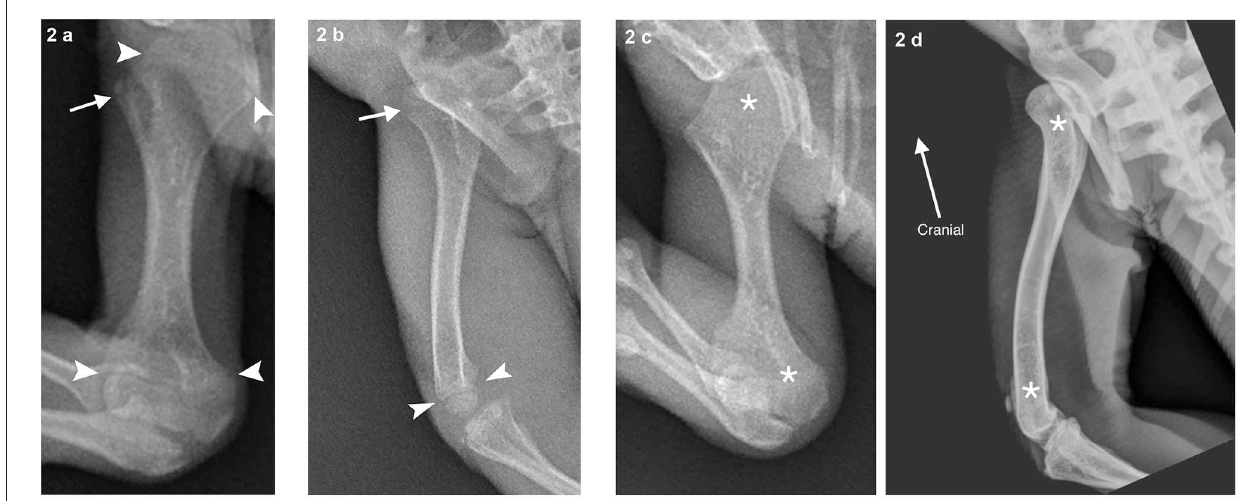
FIGURE 2 | (a) An individual with open proximal and distal humeral physes (growth plates; indicated by arrowheads) evidenced by linear lucencies separating the metaphyses (transition from diaphysis to physis/growth plate) and epiphyses (end of the long bone that supplies the articular surface of the joint). The apohysis (separate center of ossification for attachment of soft tissue structures) of the greater tubercle is also open (arrow). (b) Demonstrates an individual (464E22425F) with visible open distal femoral physis (arrowheads) and proximal femoral physis of the femoral head (arrow). (c) (4669670B06 humerus, asterisks) and (d) (green iguana left femur, asterisks) shows an individual with closed physes in these bones for comparison.